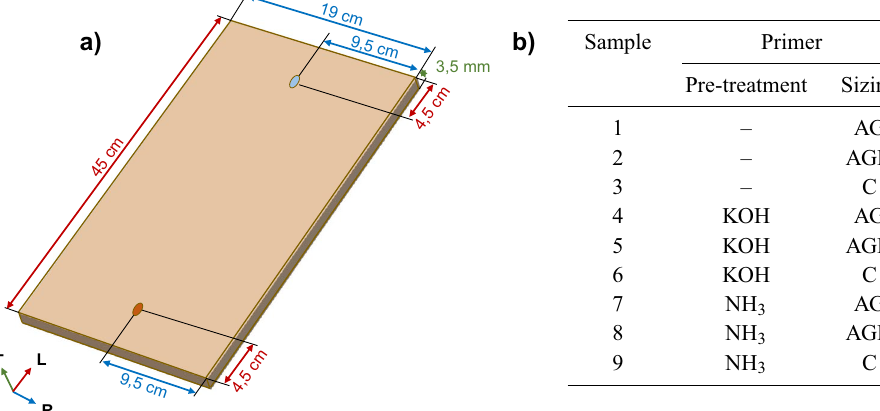
Figure 1. ( a ) Diagram of the plate geometry, with the location of the excitation (highlighted in orange) and measurement ( highlighted in light blue) points chosen for hammer impact testing. ( b ) Table listing the nine Spruce plates and details on the different primers